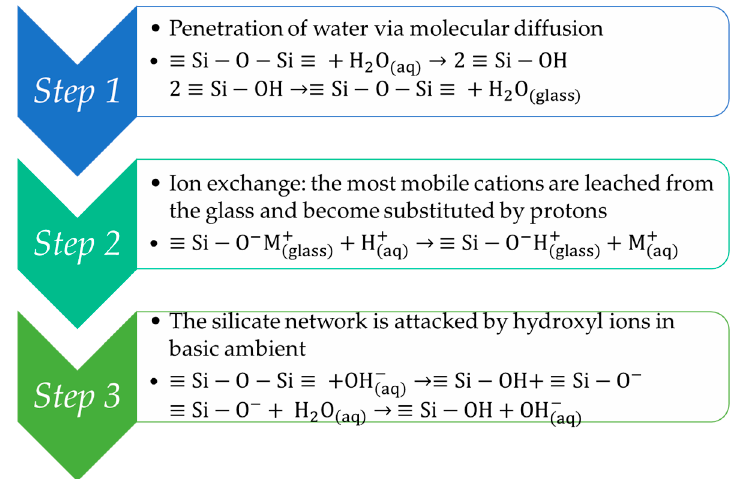
Figure 5. Progressive chemical reactions that lead to the corrosion of glass induced by aqueous environment.